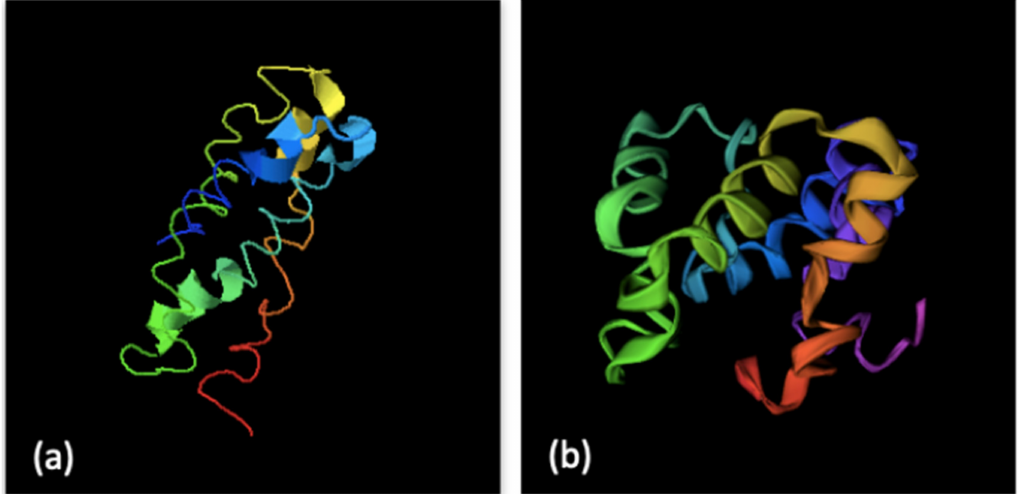
Figure 4. Protein 3D structure model of Round 3.1 using ( a ) the I-TASSER model and ( b ) the QUARK